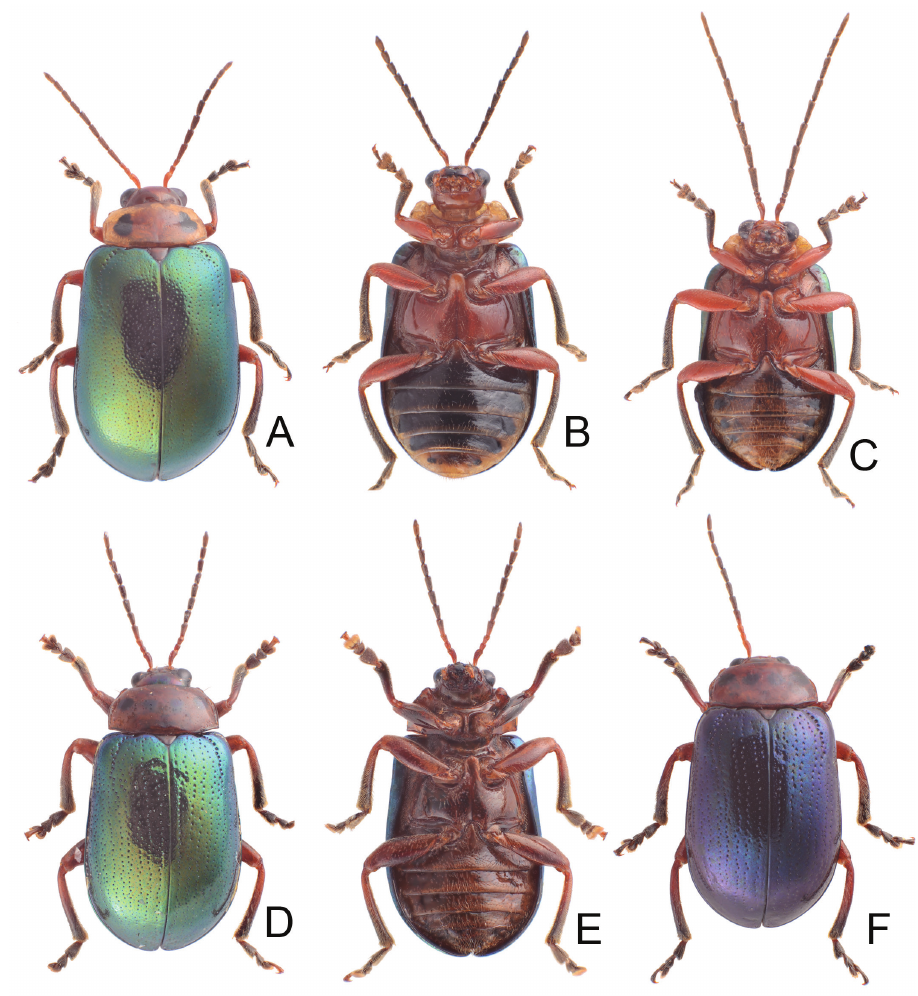
Figures 12. Habitus of Gallerucida species. A G. shirozui Kimoto, female, dorsal view B Ditto, ventral view C G. shirozui Kimoto, male, color variation, ventral view D G. thoracica (Jacoby), male, dorsal view E Ditto, ventral view F G. thoracica (Jacoby), male, color variation, dorsal view. (Fig. 13G) large, about 0.6× as long as penis, composed of one median sclerite and one pair of lateral sclerites, median sclerite longitudinal, straight in lateral view, with dorsal processes at apical 1/5, with dense setae along apical margin of process, lateral sclerites longitudinal but much shorter, about 0.5× as long as median sclerite, strongly curved near apex, apices concave. Gonocoxae (Fig. 13H) elongate, connected from base to basal 3/5, apices rounded, with dense elongate setae; base wide. Ventrite VIII (Fig. 13E) longitudinal, apical margin truncate but laterally membranous; with sparse short setae along and inside apical margin; spiculum extremely slender. Receptacle